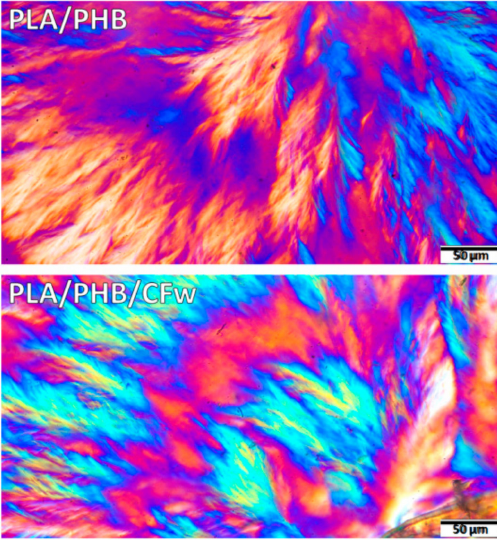
Figure 6. Polarized optical micrographs ( × 40) of isothermally crystallized PLA/PHB and PLA/PHB/CFw biocomposite at 130 ◦ C for 24